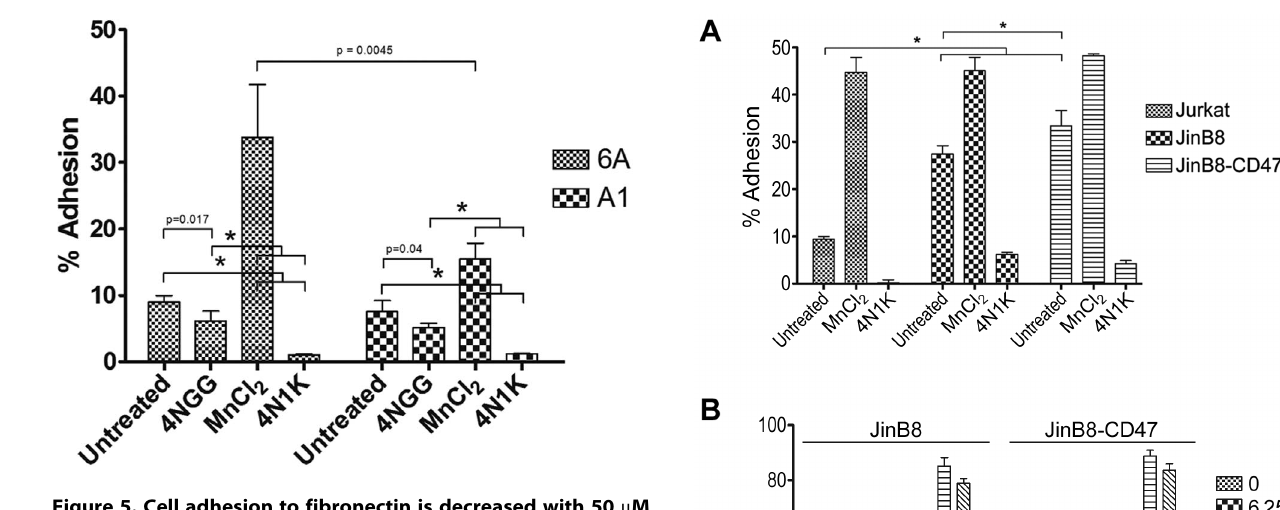
Figure 5. Cell adhesion to fibronectin is decreased with 50 m M 4N1K treatment. Jurkat 6A and A1 cells were labeled with Celltracker Green, then treated with buffer, 50 m M 4NGG, 50 m M 4N1K, or 1 mM MnCl 2 for 20 min prior to seeding onto fibronectin-coated wells. In-well fluorescence was measured using a spectrofluorometer both before and after washes to remove non-adherent cells, and % adhesion was calculated as stated in methods and materials. Data as plotted are the means 6 standard deviation for three replicate samples of one experiment (*, p , 0.001).